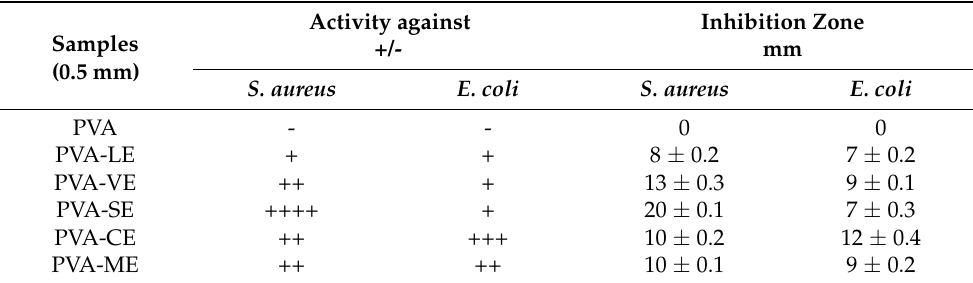
Table 3. Inhibition zone diameters of PVA and PVA films loaded with plant